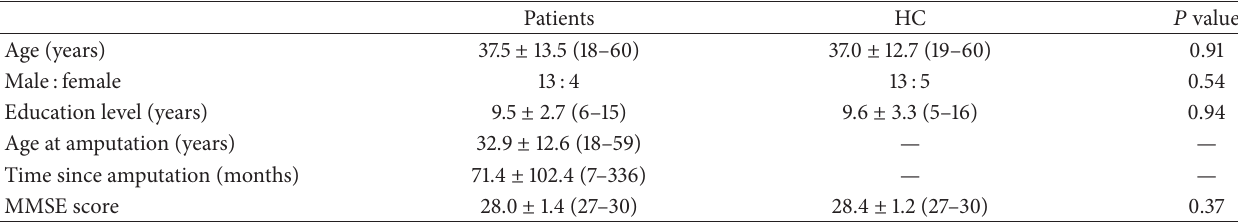
Table 1: Demographic characteristics of the